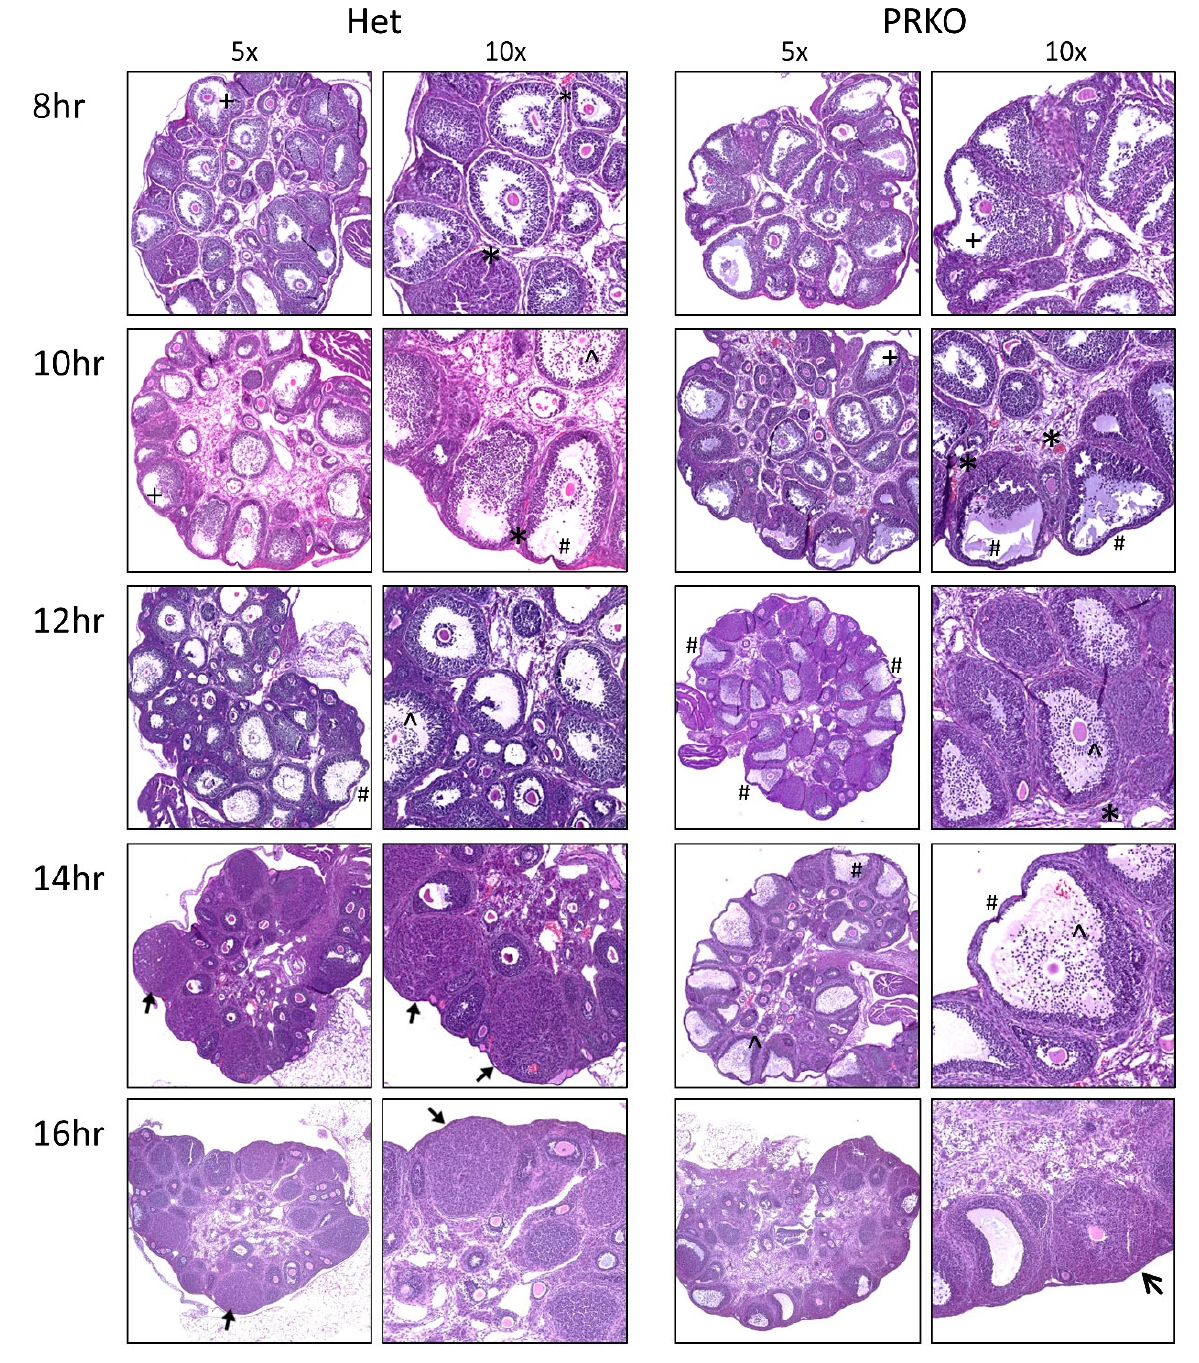
Figure 2. Histological analysis of PRKO ovaries demonstrates specific defect in follicular rupture. Ovaries were collected from PRKO and heterozygous (Het) littermates at 8, 10, 12 h timepoints post-hCG and 14 h, and 16 h timepoints, after ovulation has normally occurred. Ovary sections were stained with H&E to analyze histological phenotypes including ˆ COC expansion, + granulosa cell accumulation at the follicle base, # thinning of the apical wall, * vascularization, luteinization, unruptured luteinized follicles. Representative examples from histology performed on ovaries from 3 mice per timepoint.